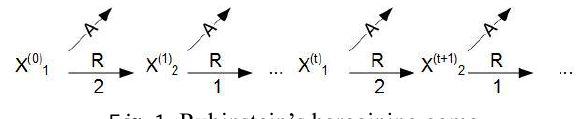
Fig. 1. Rubinstein’s bargaining